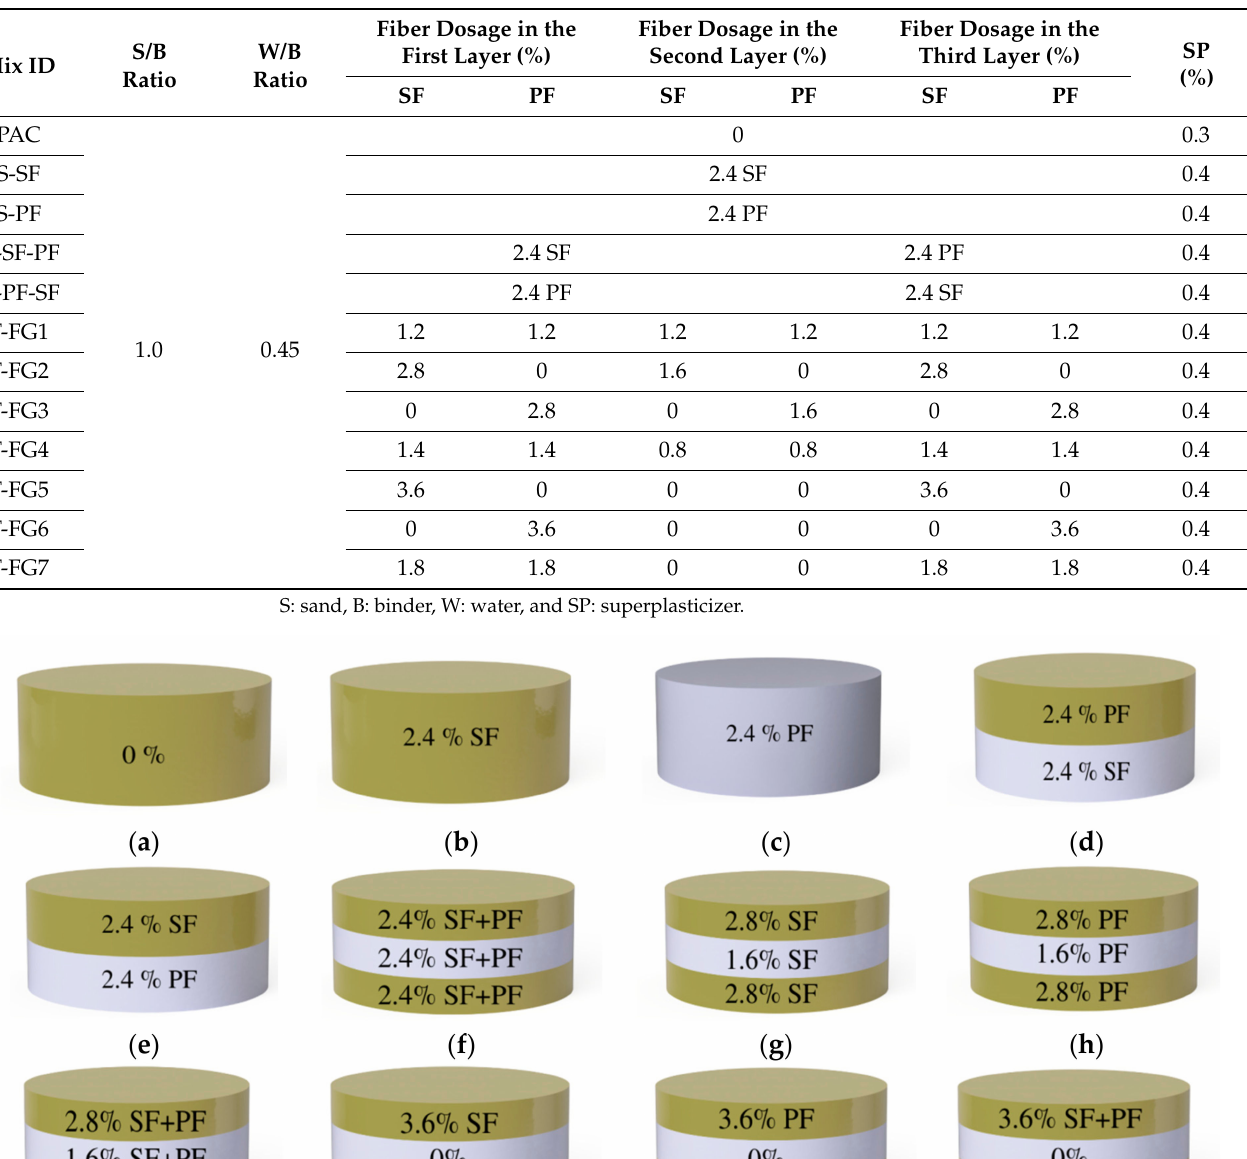
Table 2. Mixing details of developed FPAFC.